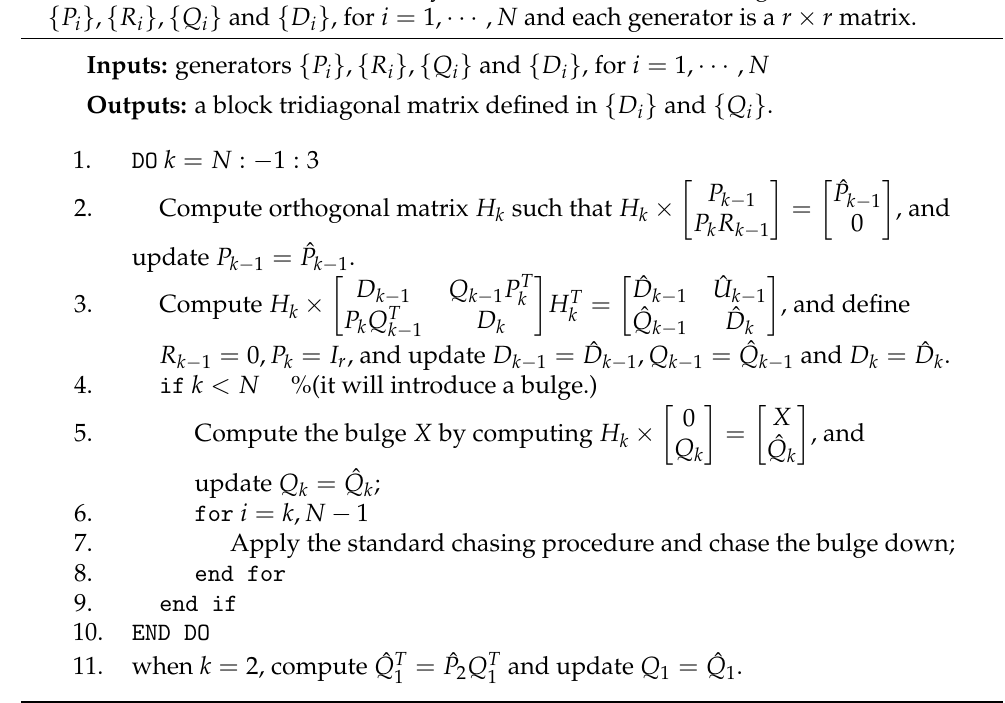
Algorithm 1: (Symmetric banded reduction algorithm for symmetric SSS